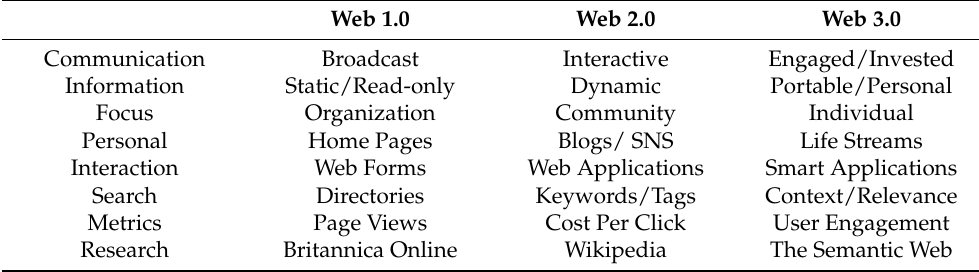
Figure 9. Web development. Table 4. Characteristics of each element according to the development of Web 1.0, Web 2.0, and Web 3.0.